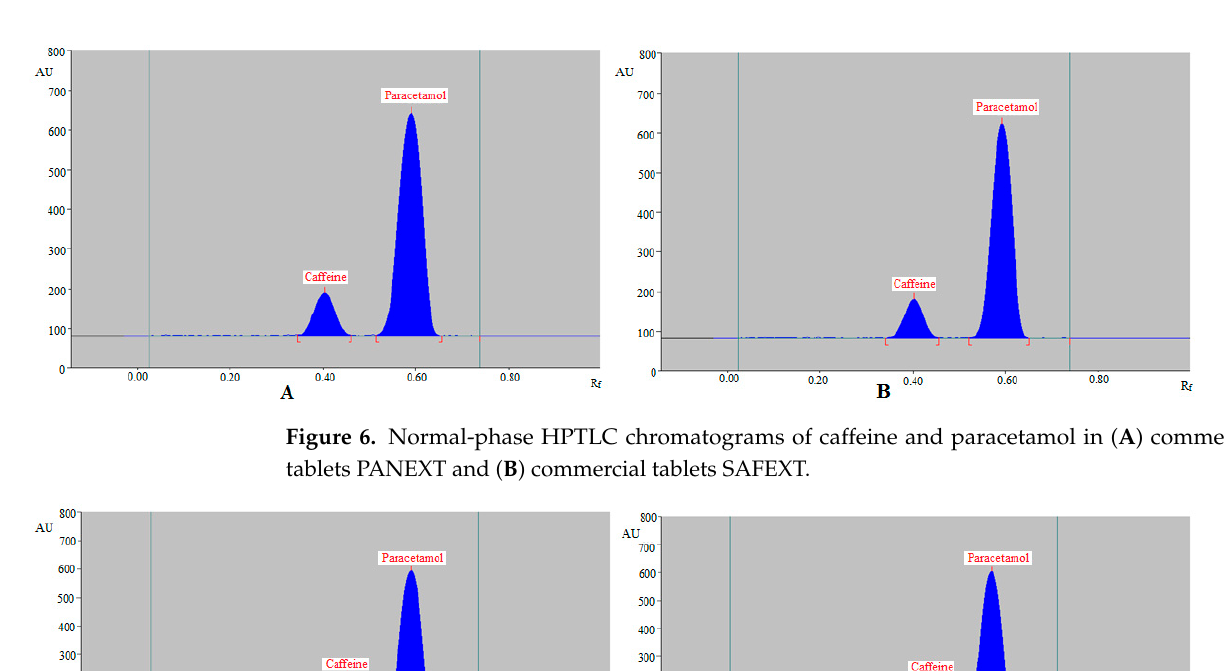
Figure 6. Normal ‐ phase HPTLC chromatograms of caffeine and paracetamol in ( A ) commercial tab ‐ lets PANEXT and ( B ) commercial tablets SAFEXT.